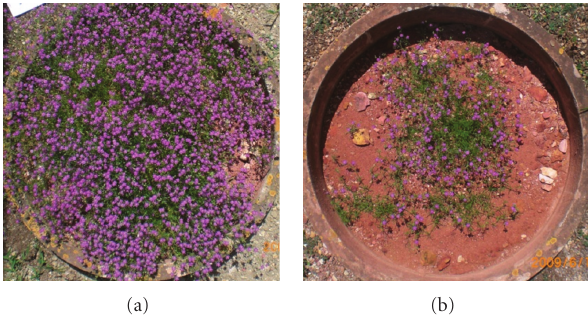
Figure 5: Growth of three species native to soils derived from a pyrite mine. Mine soil received 0.4% of polyacrylate polymers (a) or was left unamended (b).